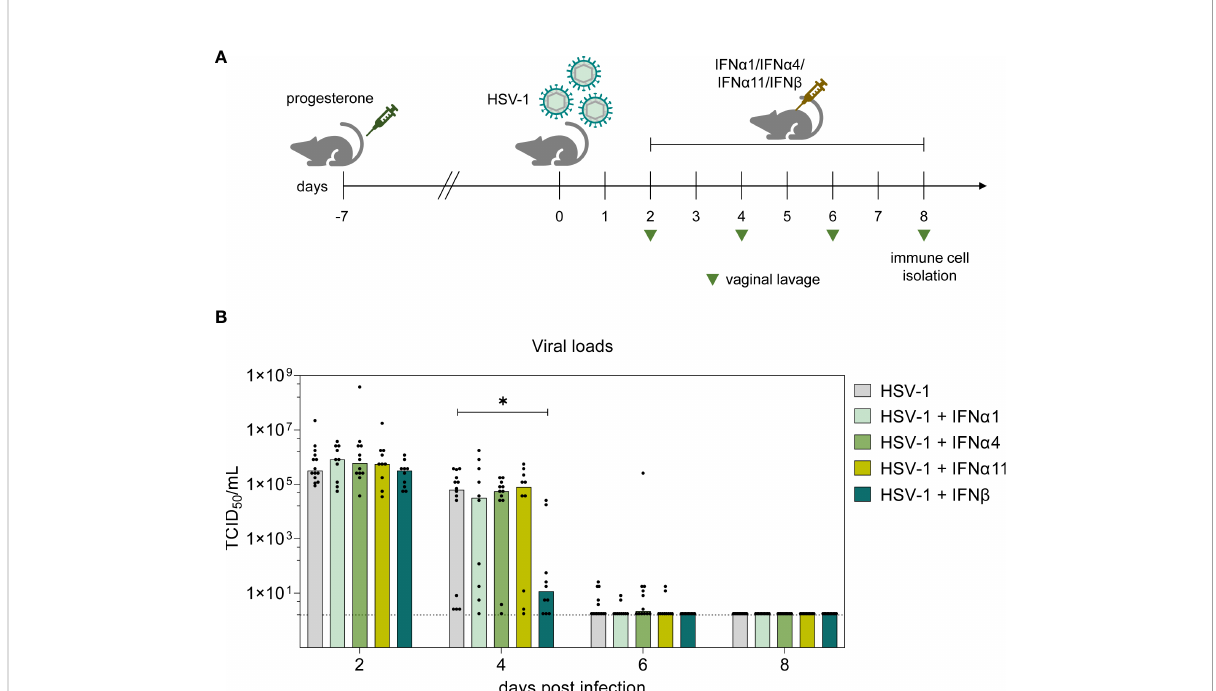
FIGURE 1 Antiviral activity of type I IFNs during vaginal HSV-1 infection on day 8 p.i. (A) Experimental setup for the in vivo assessment of type I IFN activities in genital HSV-1 infections. Female C57BL/6 mice were pretreated with 2.5 mg medroxyprogesterone acetate one week before infection. For intravaginal infection, mice were inoculated with 1×10 7 TCID 50 of HSV-1 F or left uninfected (naive control). Infected mice were assigned to different treatment groups (IFN a 1, IFN a 4, IFN a 11, IFN b ) receiving daily injections of respective murine type I IFN subtypes (8000 U) for six consecutive days starting on day 2 p.i. or left untreated (HSV-1). From day 2 p.i. until day 8 p.i. , liquids from vaginal tract lavages were collected every second day for determination of viral loads, shown by light green triangles. After 8 days, spleens and vaginal tracts were isolated for further analysis of immune responses. (B) Viral titers of vaginal lavages were determined by endpoint dilution assay. Bars indicate the median virus titer of each group (HSV-1 n = 14 mice, HSV-1 + IFN a 1 n = 10 mice, HSV-1 + IFN a 4 n = 12 mice, HSV-1 + IFN a 11 n = 10 mice, HSV-1 + IFN b n = 10 mice). Dashed line marks the detection limit. Statistical analyses were conducted with the nonparametric Kruskal-Wallis test. Statistical signi fi cance between individual study groups is represented by * P <